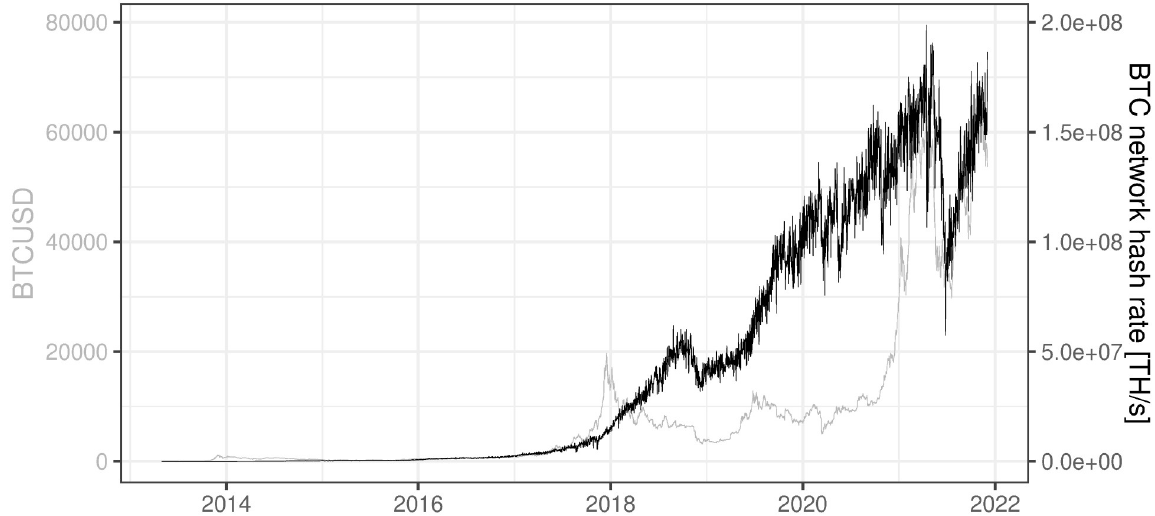
Fig 10. BTC network hash rate. Note: Data covers the period between 2013/05/01 to 2021/12/03. Source: https://api.blockchain.info/charts/ hash-rate?format=csv.